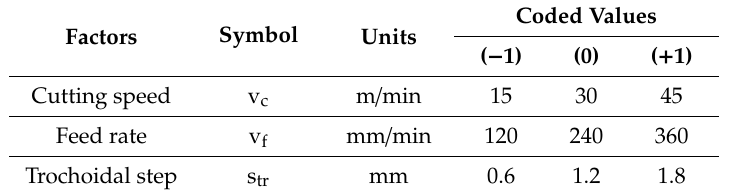
Table 3. Process factors and their coded values.